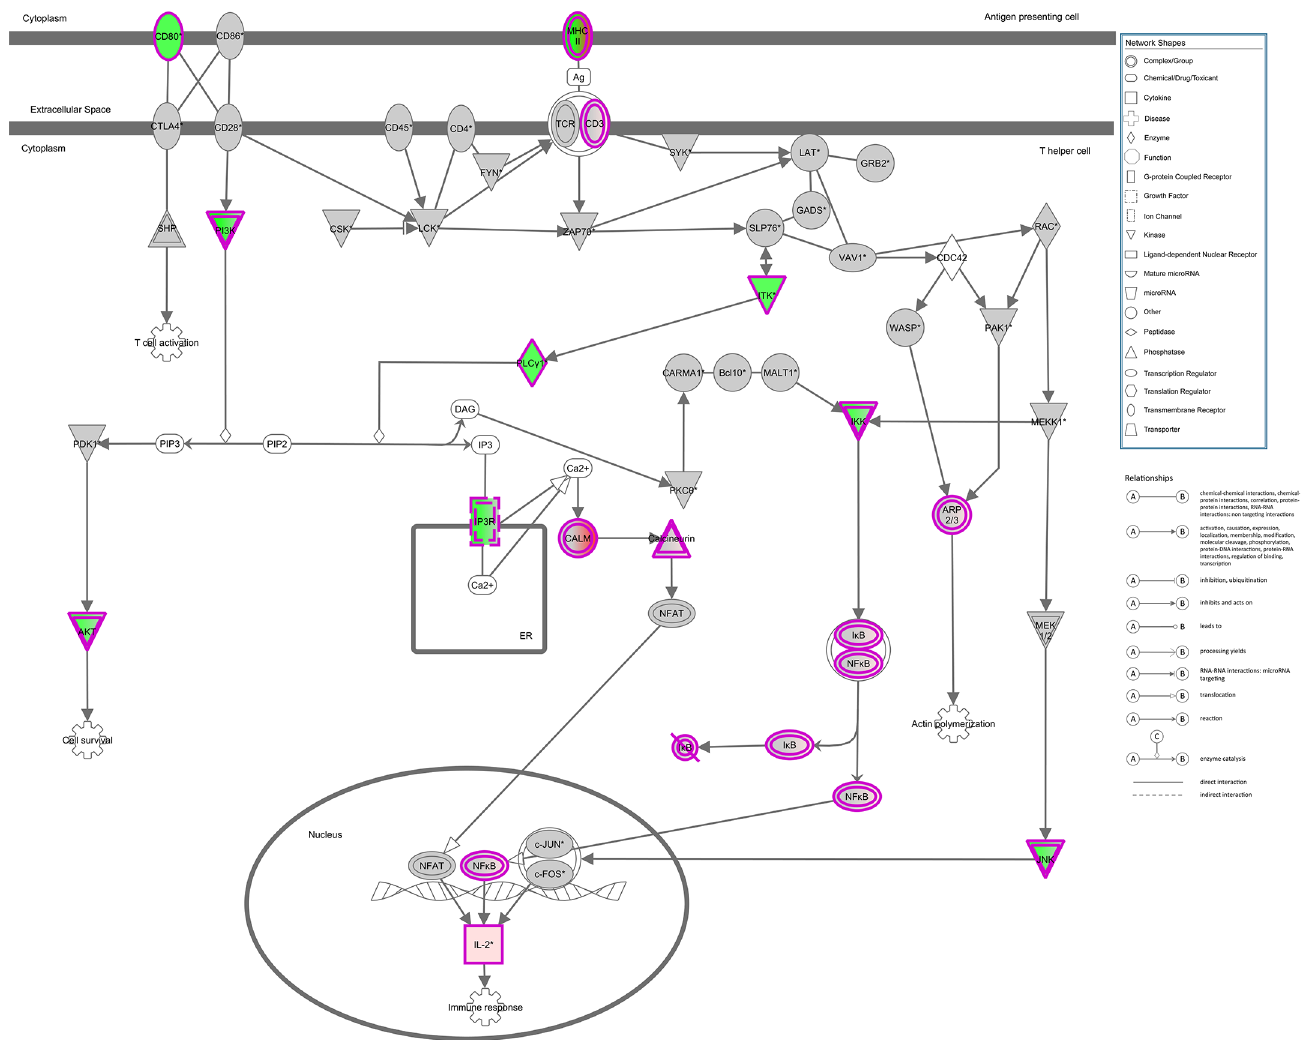
Fig 3. Canonical pathway for CD28 Signaling in T Helper Cells overlaid with hits from union of RIP-Seq and RNA-Seq analyses. Significant pathway nodes are shaded according to size of fold change (red > 1; green < 1), with white nodes indicating genes that were not detected in the samples and gray indicating genes that were detected, but not significant. Nodes with multicolor gradients denote nodes with significant genes with fold changes in different directions (see Table 3 for more details). Fold change is defined as KO/CTL (RNA-Seq) or IP/CTL (RIP-Seq). Colored double borders indicate that the molecule is a